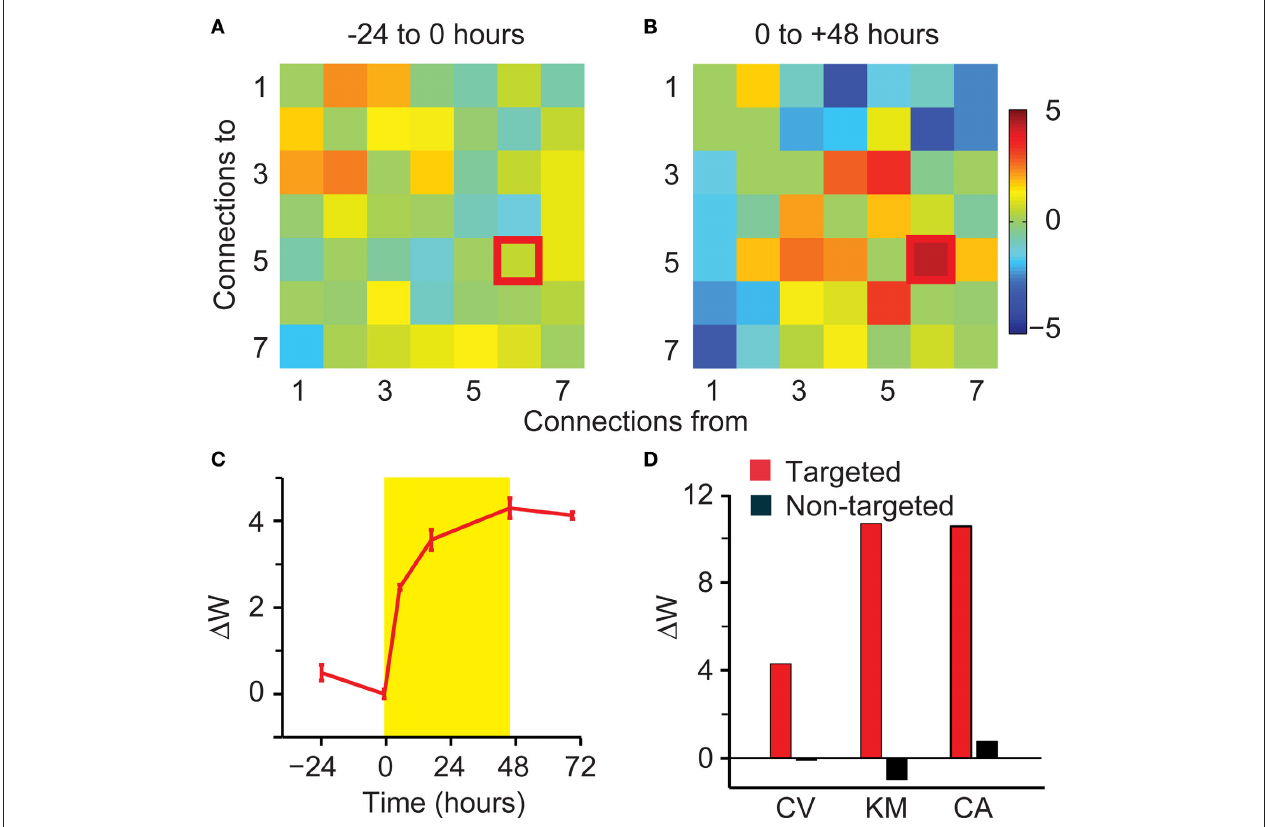
rate-limited stimulation at 5-ms latency. (C) Timecourse of trigger-to-target ∆ W . (D) Summary of ∆ W for targeted (red) and the average of all non-targeted connections